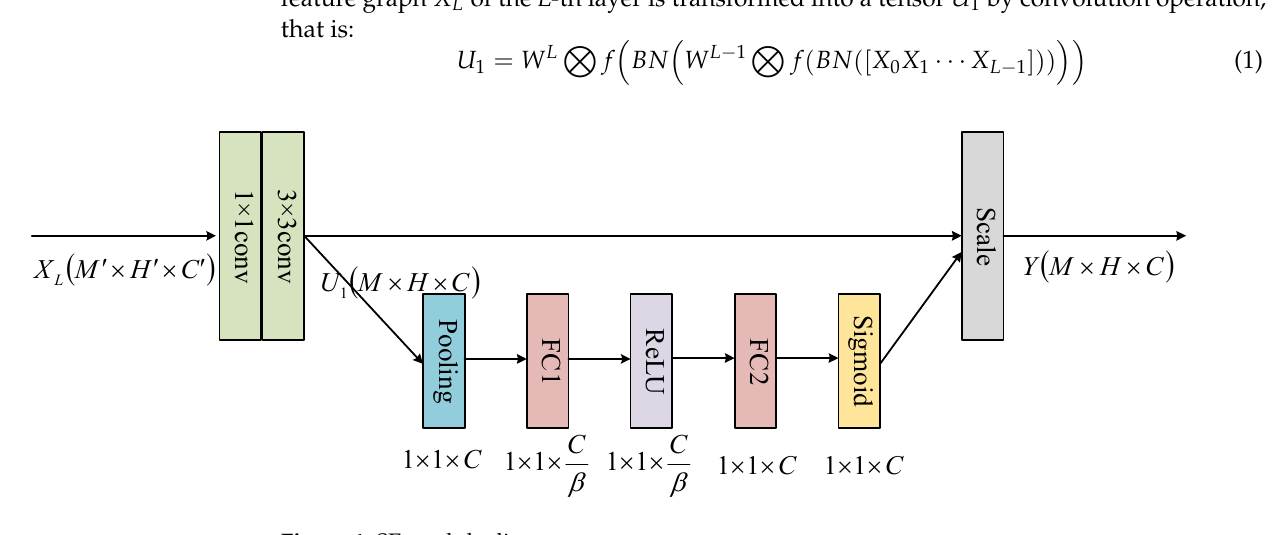
Figure 4. SE module